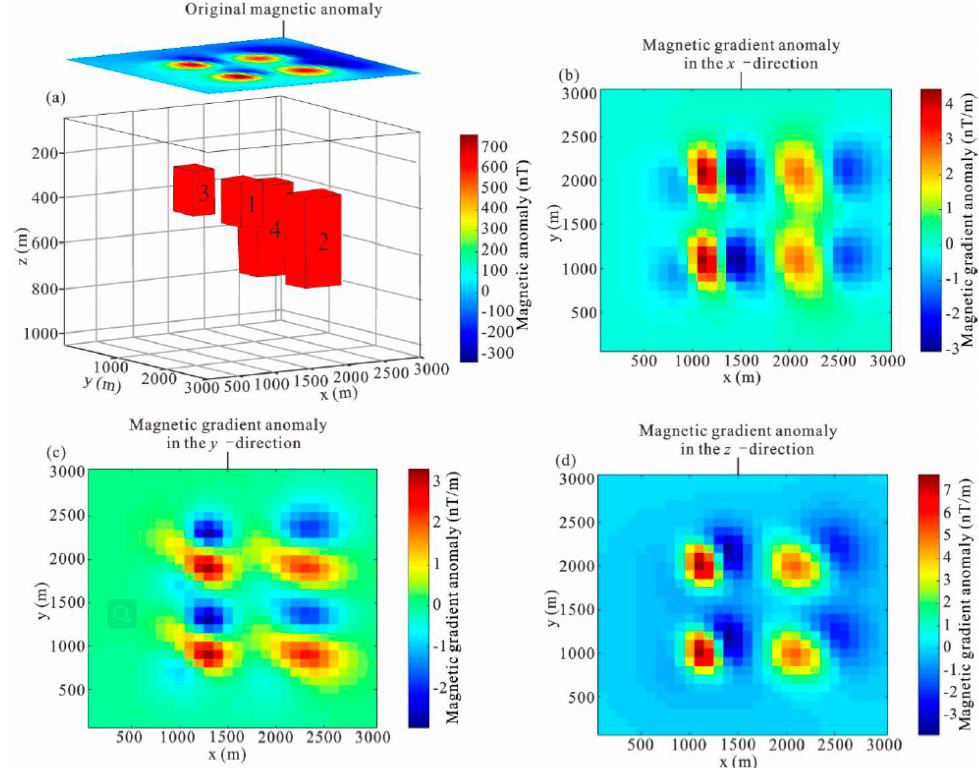
Figure 9. 3D view of the 4 prisms and corresponding magnetic and gradient anomalies. ( a ) 3D view of the 4 models and the magnetic anomaly. ( b ) Magnetic gradient anomaly in the x -direction.